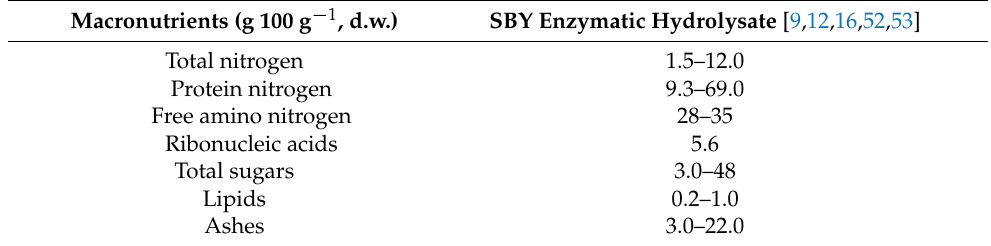
Table 1. Macronutrients composition in spent brewer’s yeast protein hydrolysates produced using enzymatic